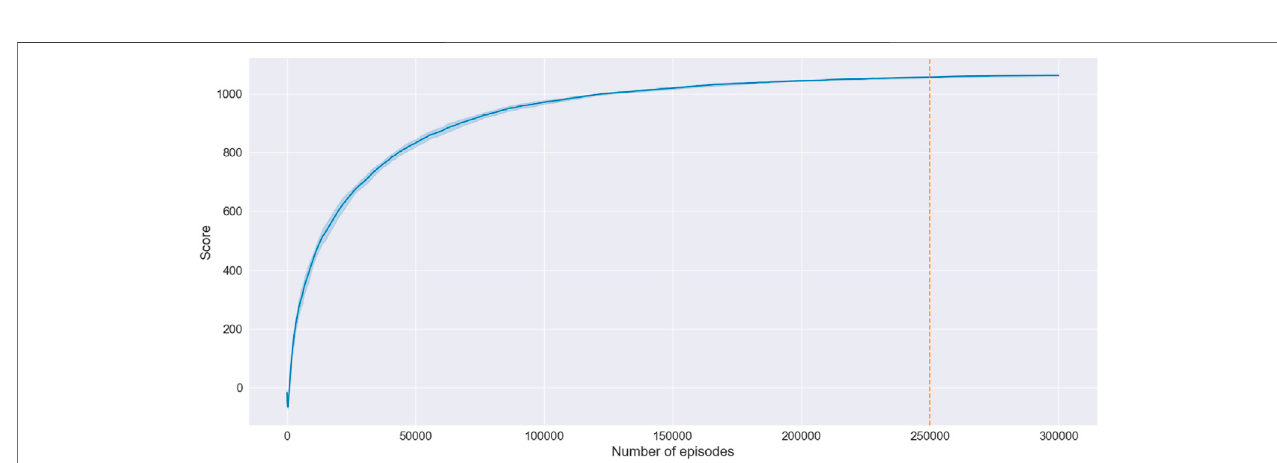
FIGURE 4 | An example of a learning curve of the training process. The bold line and the shaded region show the mean and the standard deviation of fi ve runs.